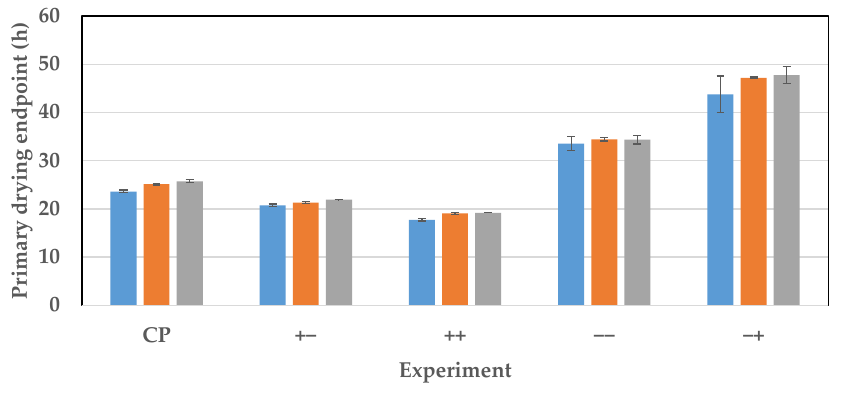
Figure A1. Position-specific values of K V .